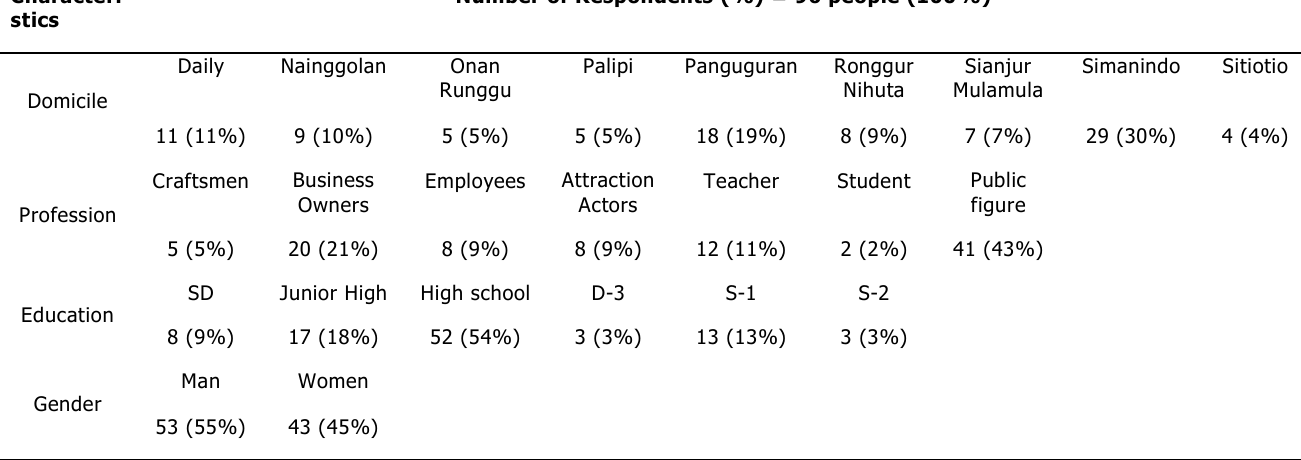
Table 3 . Characteristics of